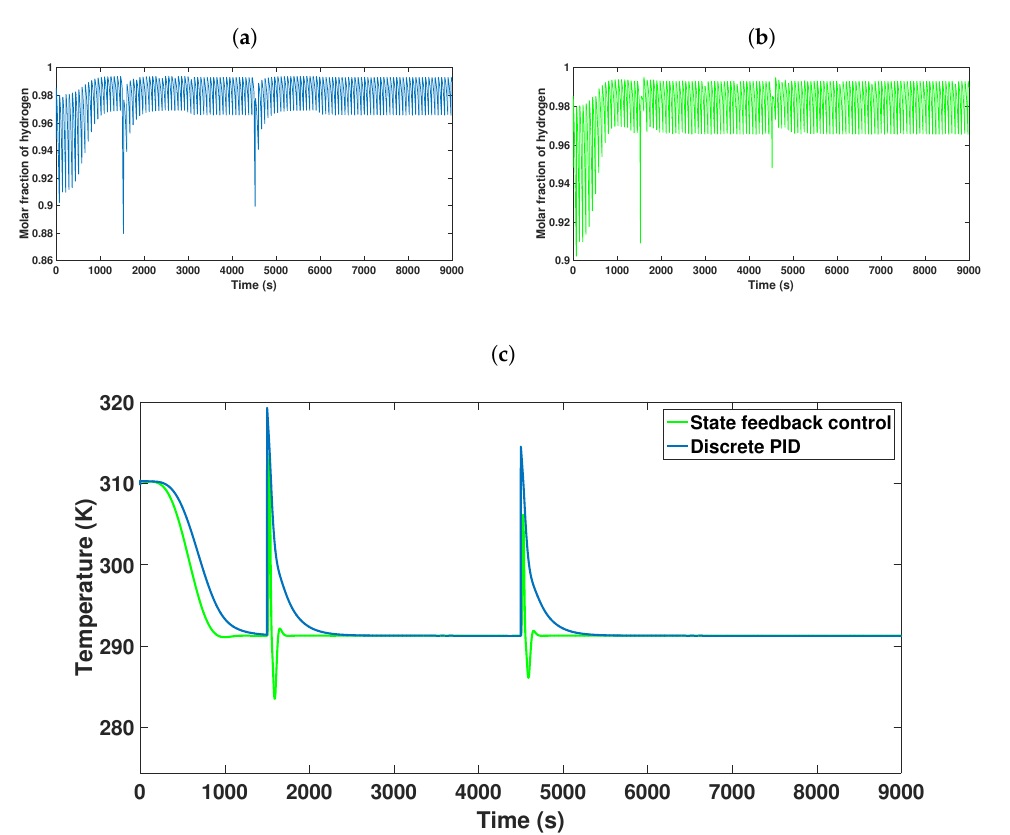
Figure 20. Validation of the controllers from a change of trajectory and the presence of two dis- turbances. ( a ) Purity obtained with trajectory tracking and attenuation of two disturbances from the control signals generated by the discrete PID. ( b ) Purity obtained with trajectory tracking and attenuation of two disturbances from the control signals generated by state feedback. ( c ) Discrete PID and status feedback control